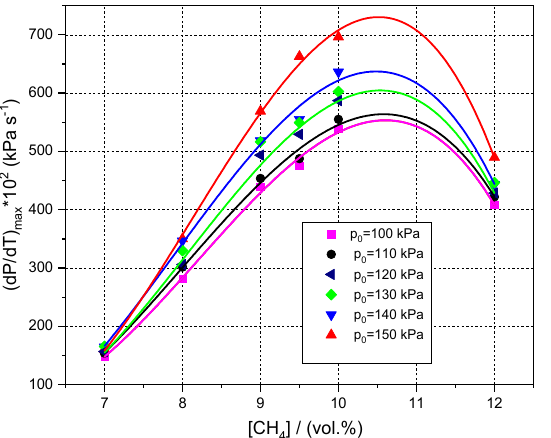
Figure 10. Experimental maximum rate of pressure rises at different initial pressures and composition for CH 4 –air mixtures.